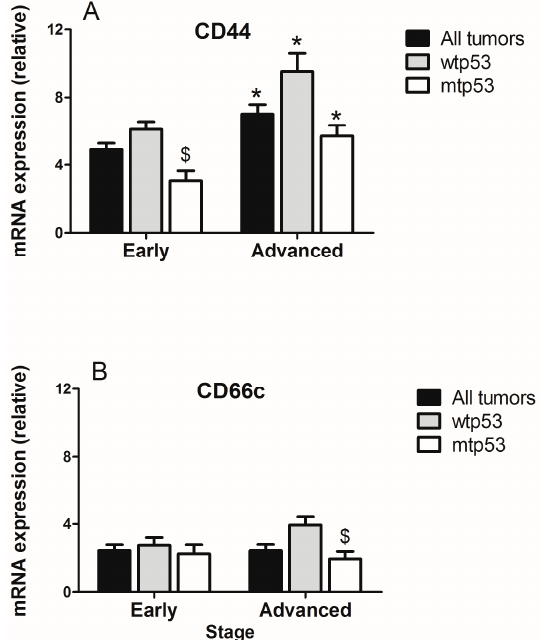
Figure 4. Relative expression of ( A ) CD44 and ( B ) CD66c in early stages (stage I + stage II) versus advanced (stage III + stage IV) colorectal tumors considering the status of p53. Data represent mean ± S.E.M. * p < 0.05 versus early; $ p < 0.05 versus wtp53.